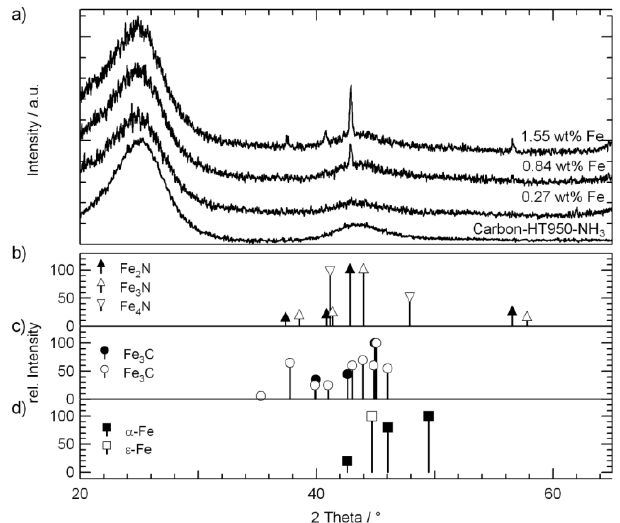
Figure 4. The phase inclusion of ferrous nitride (for reference only) JCPDS file [47]. Adapted with permission from Ref. [47] (Springer, 2016). ( a ) X-ray diffractograms of catalysts with different amounts of iron and, for comparison, of the Fe-free, ammonia-treated microporous carbon, ( b ) as compared to diffraction patterns of several iron nitrides. ( c ) carbides, and ( d ) metallic iron phases ( d ). Reference data were taken from the JCPDS database (released in